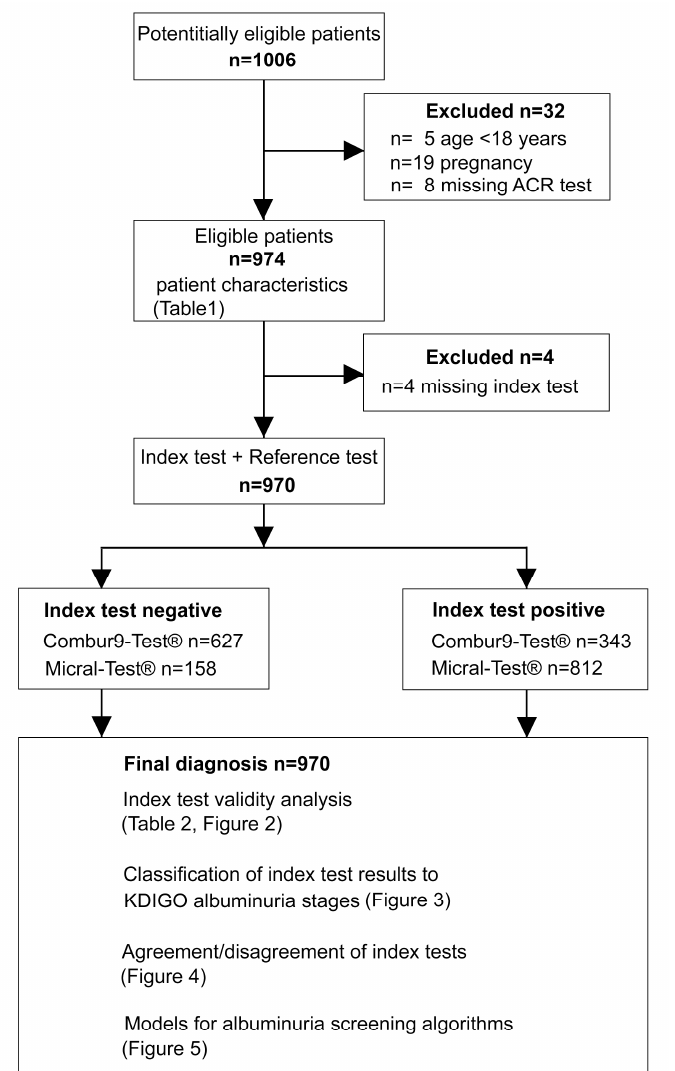
Figure 1. Study flow: ACR: albumin-to creatinine ratio; KDIGO: Kidney Disease Improving Global